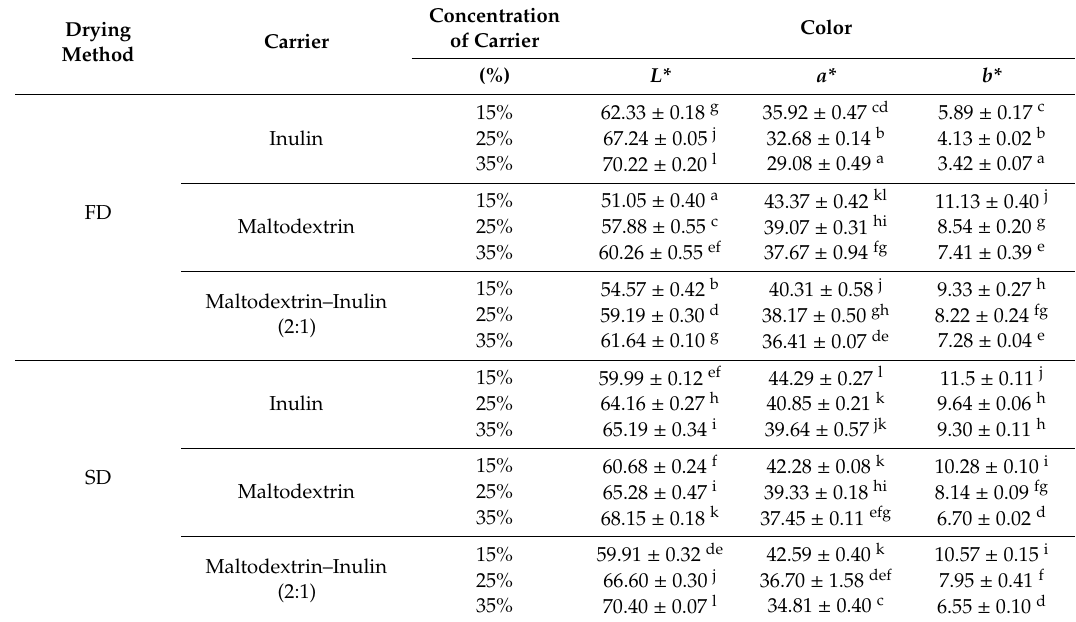
Table 2. The color parameters (CIE L* a* b* ) of cranberry powders obtained after freeze- and spray-drying ( n = 5, average ± standard